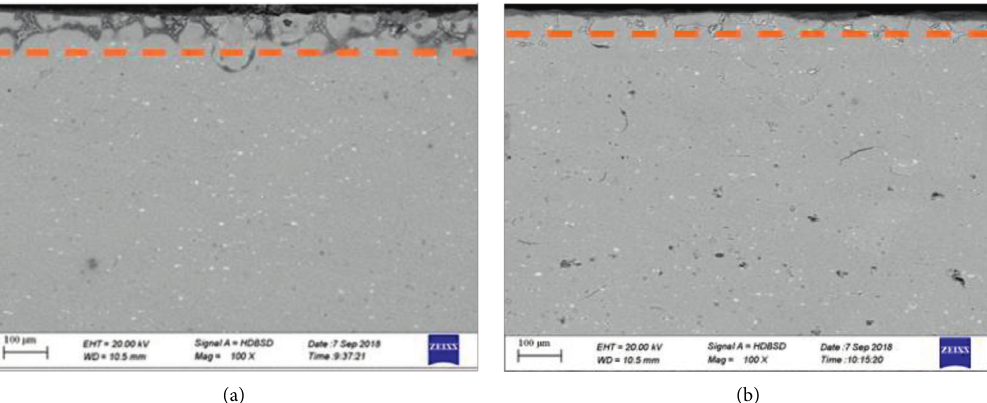
Figure 13: Microstructures of the 4343/3003/4343 clad sheets after brazing: (a) rolled to 40% and annealed at 360 ° C and (b) rolled to 10% and annealed at 360 °